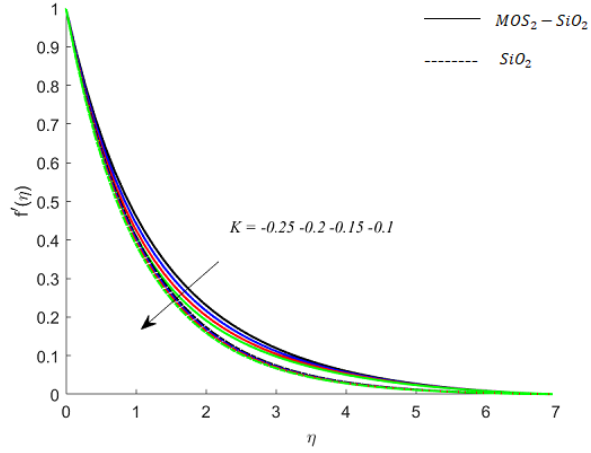
Figure 3. Influence of K on velocity when M = 0.9, Pr = 0.9, Ec = 0.2, Sc = 0.8, Bi = 0.05, β ∗ = 0.1, γ = 0.1, γ 1 = 0.1. Fluid particle motion and buoyancy force: The parameters (𝐺𝑟) (cid:3030) and (𝐺𝑟) (cid:3047) are the coefficients of terms associated with buoyancy forces that arise due to the density dif- ferences caused by the compositional and temperature differences under Boussinesq ap- proximation. For (𝐺𝑟) (cid:3030) > 0 and (𝐺𝑟) (cid:3047) > 0 , the buoyancy force is posture and assists the flow (see Figures 4 and 5), whereas when (𝐺𝑟) (cid:3030) < 0 and (𝐺𝑟) (cid:3047) < 0 , the Buoyancy force is negative and opposes the flow. This opposing behavior can be noticed during numerical